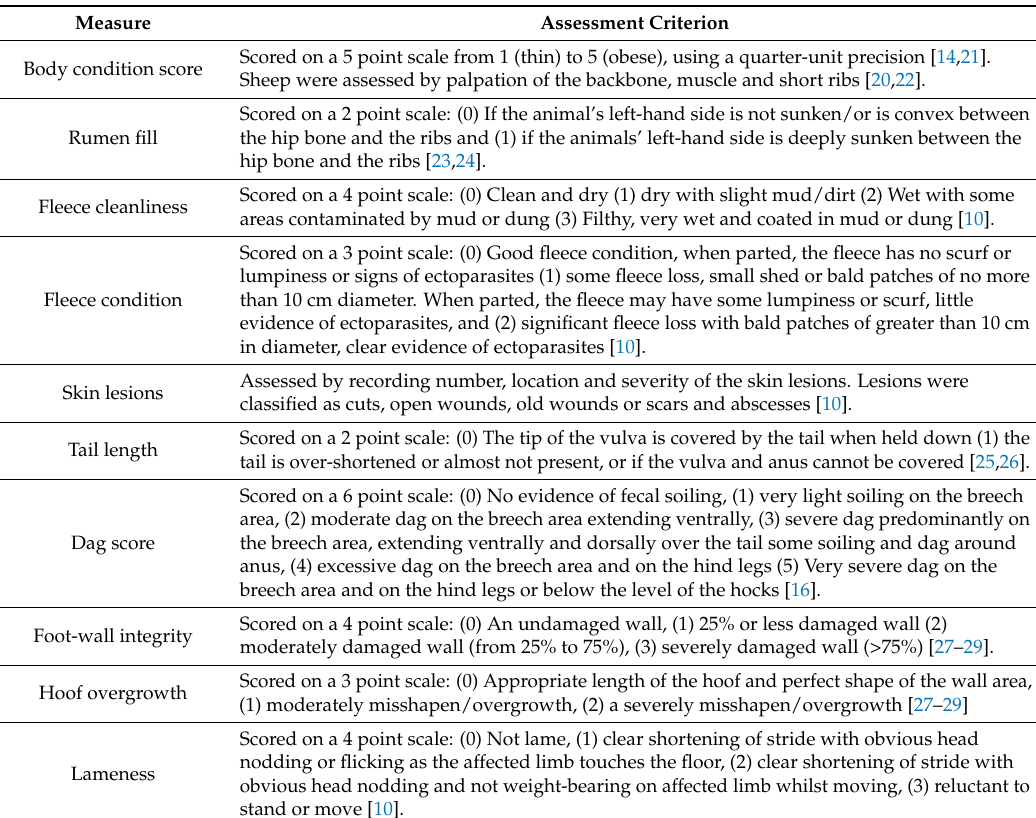
Table 1. Animal-based welfare measures used to assess the welfare of extensively managed